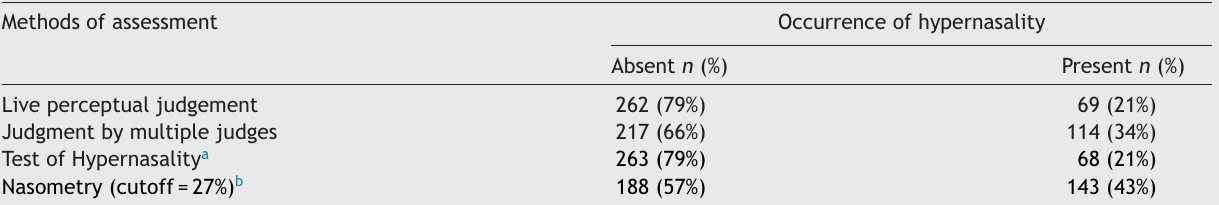
Distribution of the number and percentage of patients according to the occurrence of hypernasality in the four types of assessment.